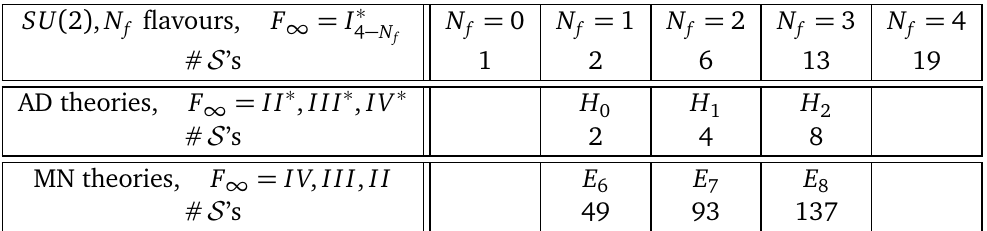
Table 8: Number of distinct rational elliptic surfaces on the extended CB of each 4d